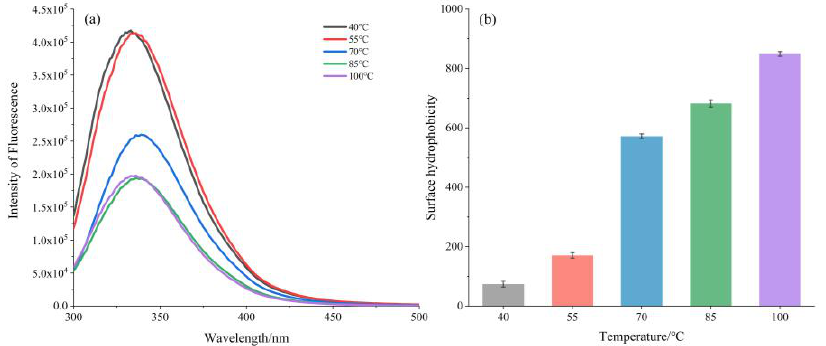
Figure 4. ( a ) Intrinsic fluorescence spectra of EBN treated under different temperature; ( b ) effects of heat treatment on S 0 of EBN soluble fractions.